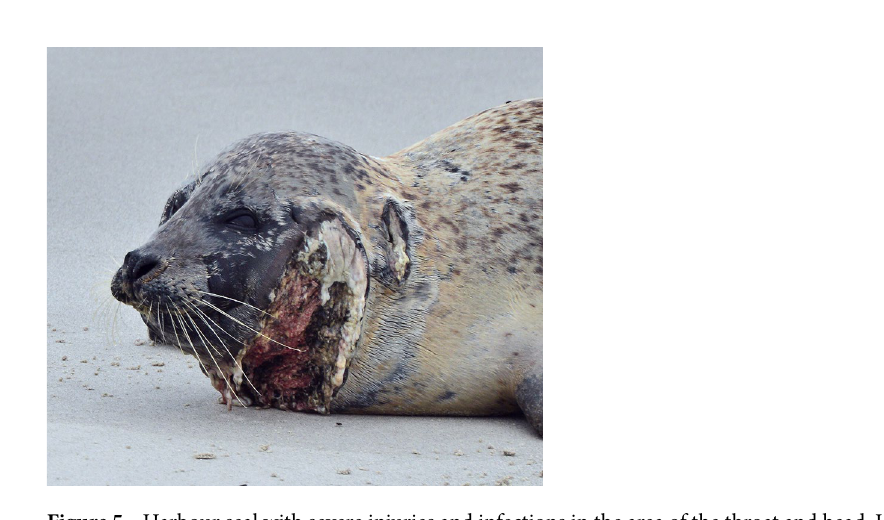
Figure 5. Harbour seal with severe injuries and infections in the area of the throat and head. Helgoland, Germany, September